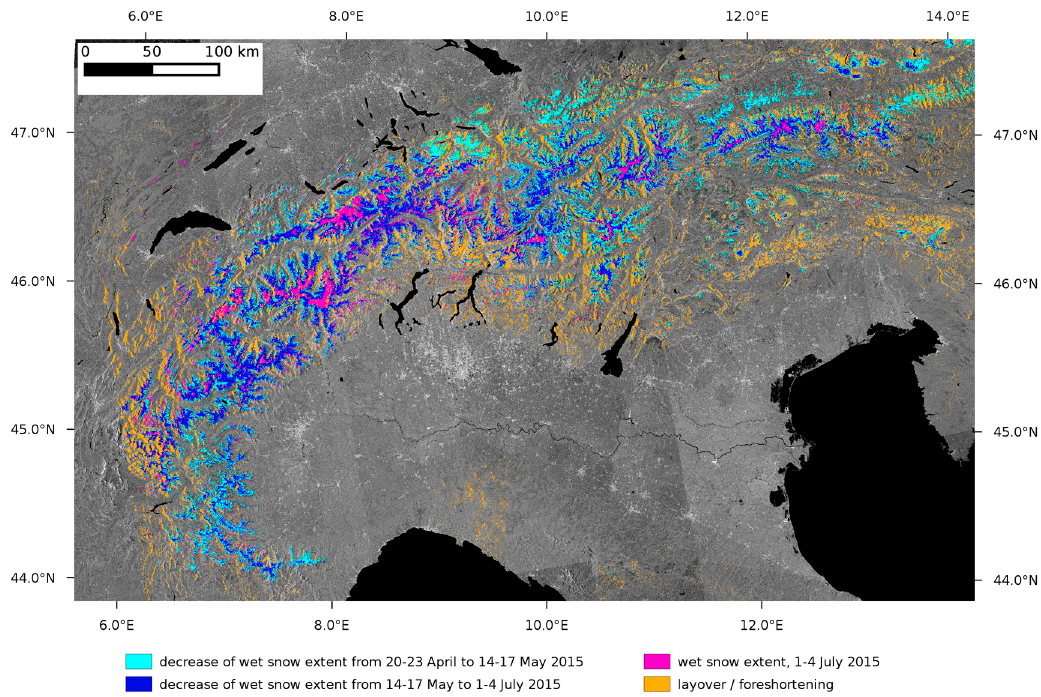
Figure 7. Map of snowmelt area extent over the Alps, derived from Sentinel-1 data of 20 to 23 April 2015 (Date 1), 14 to 17 May 2015 (Date 2), 1 to 4 July 2015 (Date 3). Light blue: decrease of snow extent between Date 1 and Date 2. Dark blue: decrease of snow extent between Date 2 and Date 3; Purple: snowmelt area on Date 3. Black: water surfaces; orange: mask of layover and foreshortening. Background: S1 SAR amplitude image, VV polarizations.